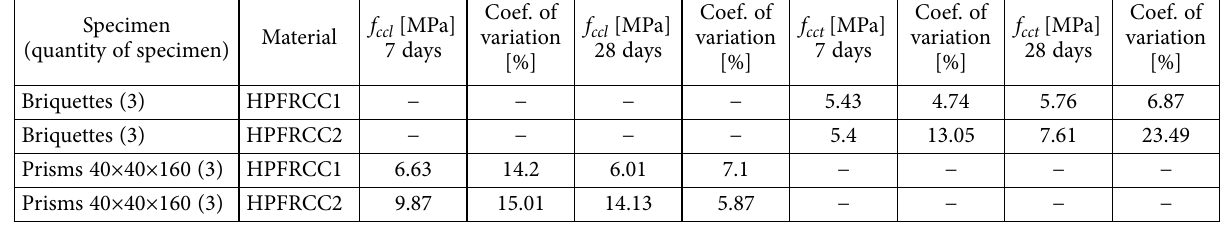
Table 5. Mechanical parameters of HPFRCC material obtained from flexural and tensile test Specimen Material (quantity of specimen)